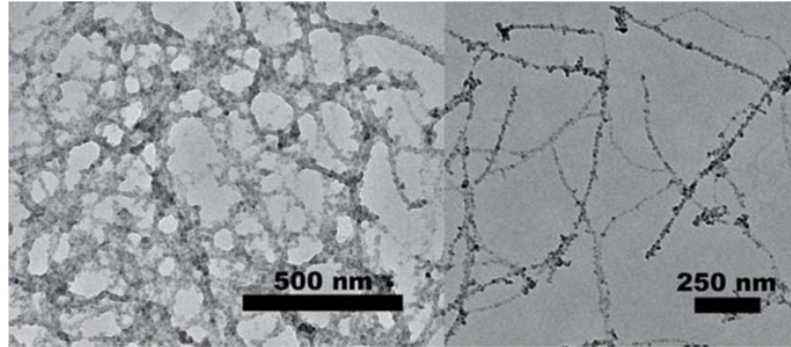
Figure 4: TEM images of α -FePO 4 · H 2 O nanowires [40].